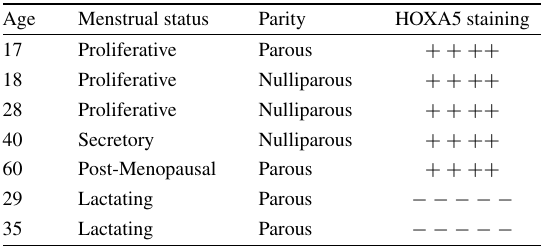
HOXA5 expression levels at various stages of normal breast deve-